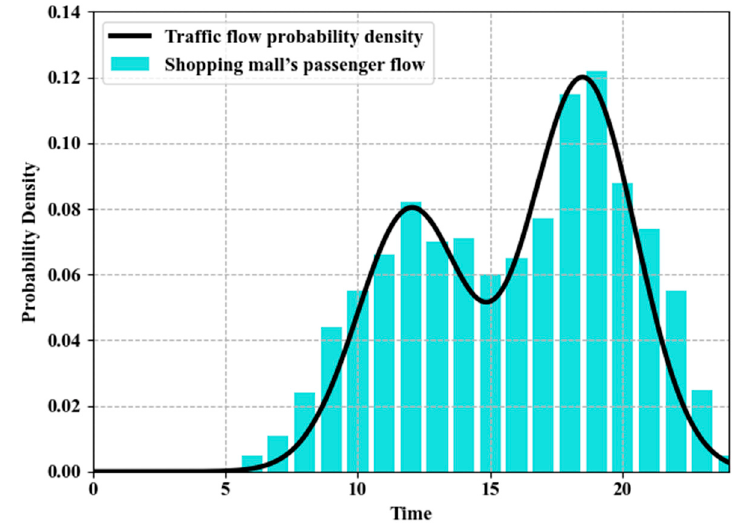
Figure 3. Shopping mall’s passenger flow and approximated traffic flow probability density.